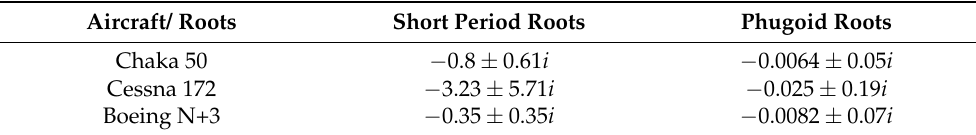
Table 4. Longitudinal dynamics characteristics of presented regional aircraft in comparison with other related